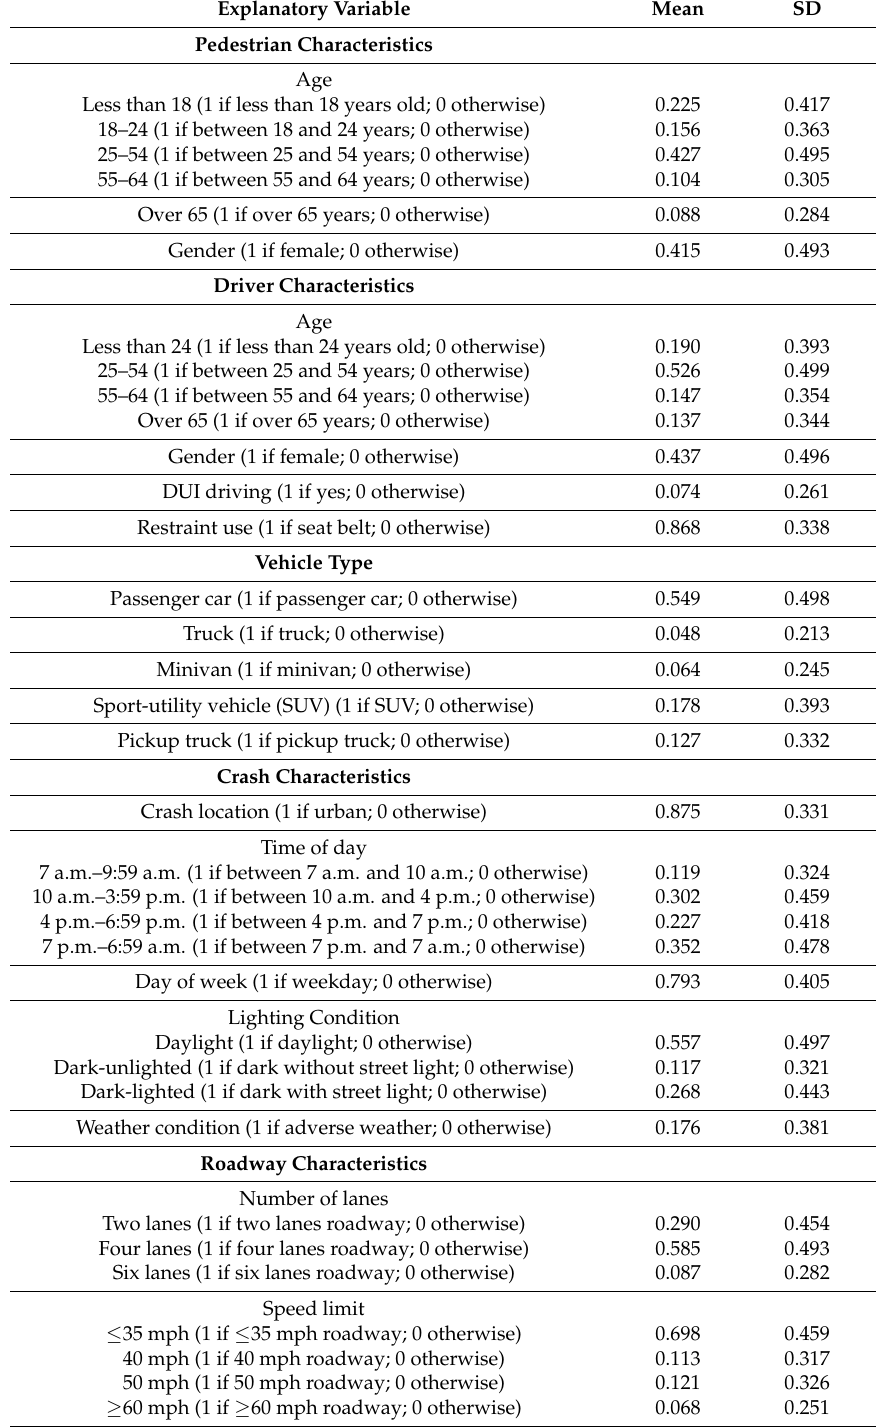
Table 1. Descriptive statistics of the explanatory